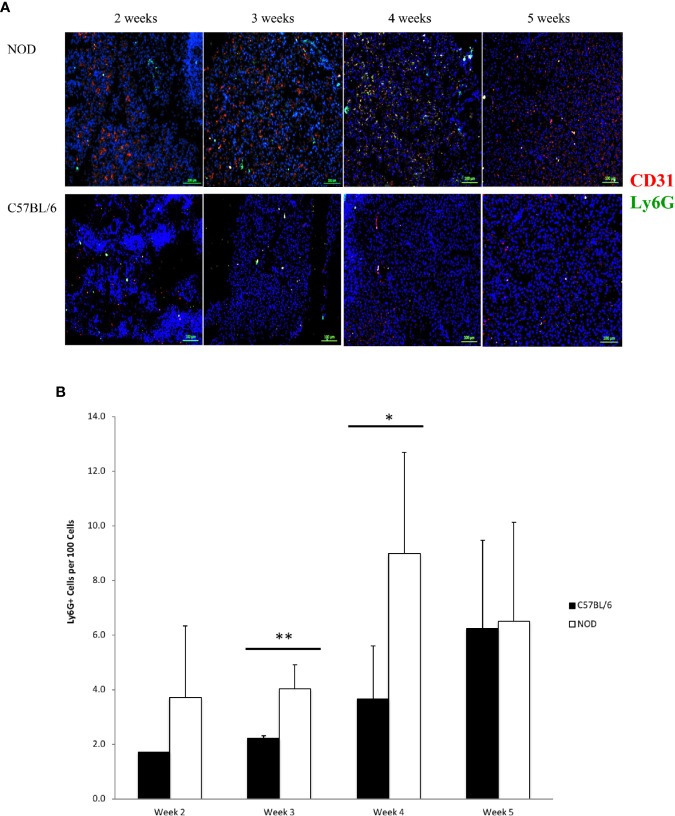
Post-natal pancreas from NOD female mice exhibit Ly6G and CD31 events. (A) Serial sections from formalin-fixed paraffin-embedded pancreata of 2-5 week old female NOD and C57BL/6 mice were stained with fluorochrome-tagged antibodies to Ly6G and CD31. Immunofluorescence shown is representative of outcomes observed in at least three individual mice of each strain. Bar at the bottom of each image represents the length of 100 μm. (B) Quantification of Ly6G+ signals in serial sections from post-natal pancreas of NOD female and C57BL/6 female mice. The number of Ly6G events and DAPI nuclear stain were determined using the QuPath Software version 0.1.2. Means of positive signals, following autofluorescence removal, were determined among three to five slides per pancreas per antibody target and presented graphically as the number of marker-positive cells per 100 total cells. Using Ly6G+ as a marker of neutrophils, their accumulation was evident at 4 weeks of age in the pancreas of NOD mice. By 5 weeks of age, most of the Ly6G+ signal was found at lower frequency. The number of Ly6G+ events is elevated in NOD, reaching significance at 3 and 4 weeks of age. Statistical significance was determined by a student’s t-test at individual weeks of age with a of p < 0.05 designated by * and p < 0.01 designated by **.